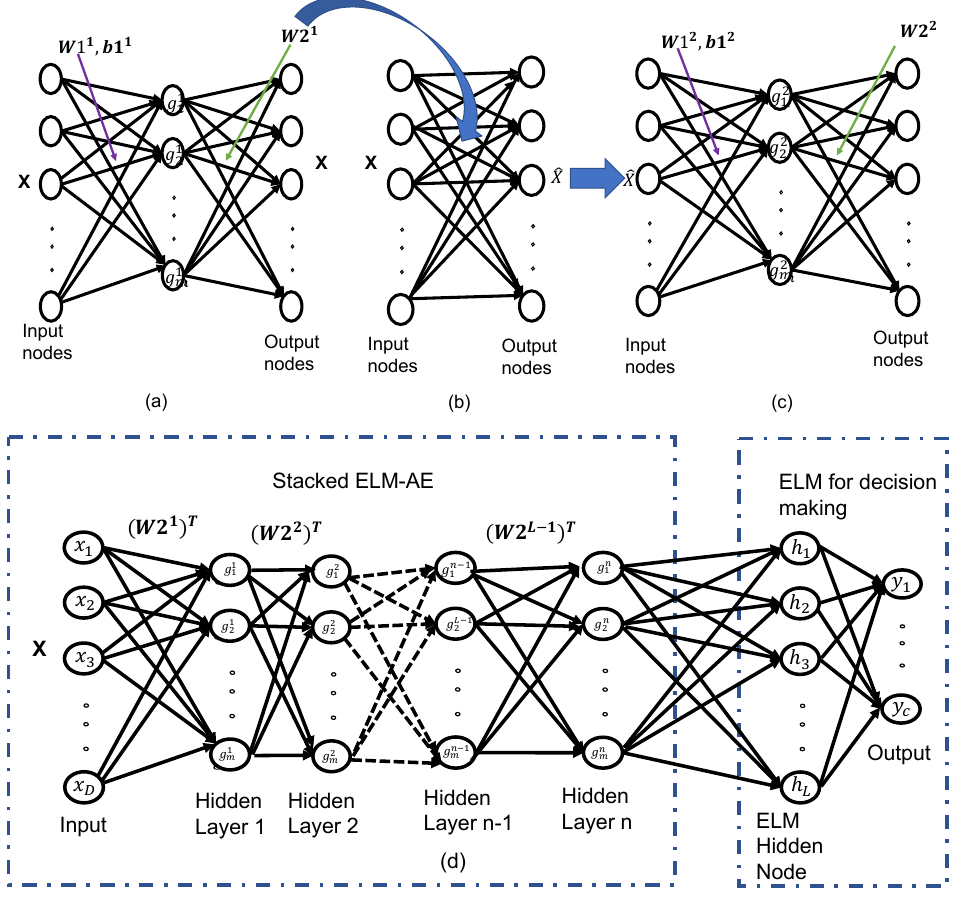
Figure 4. Architecture of the ML-ELM. It consists of feature encoding using stacks of AEs, a multilayer network with a randomized input weight and bias, and an ELM regressor for making the final decision. ( a ) is an autoencoder ( b ) extracts a new representation from input x , and ( c ) is a new autoencoder, it takes the new representation from ( b ) and extracts new features from it and ( d ) is the ML-ELM, it consist of stacks of AEs and ELM regressor for final